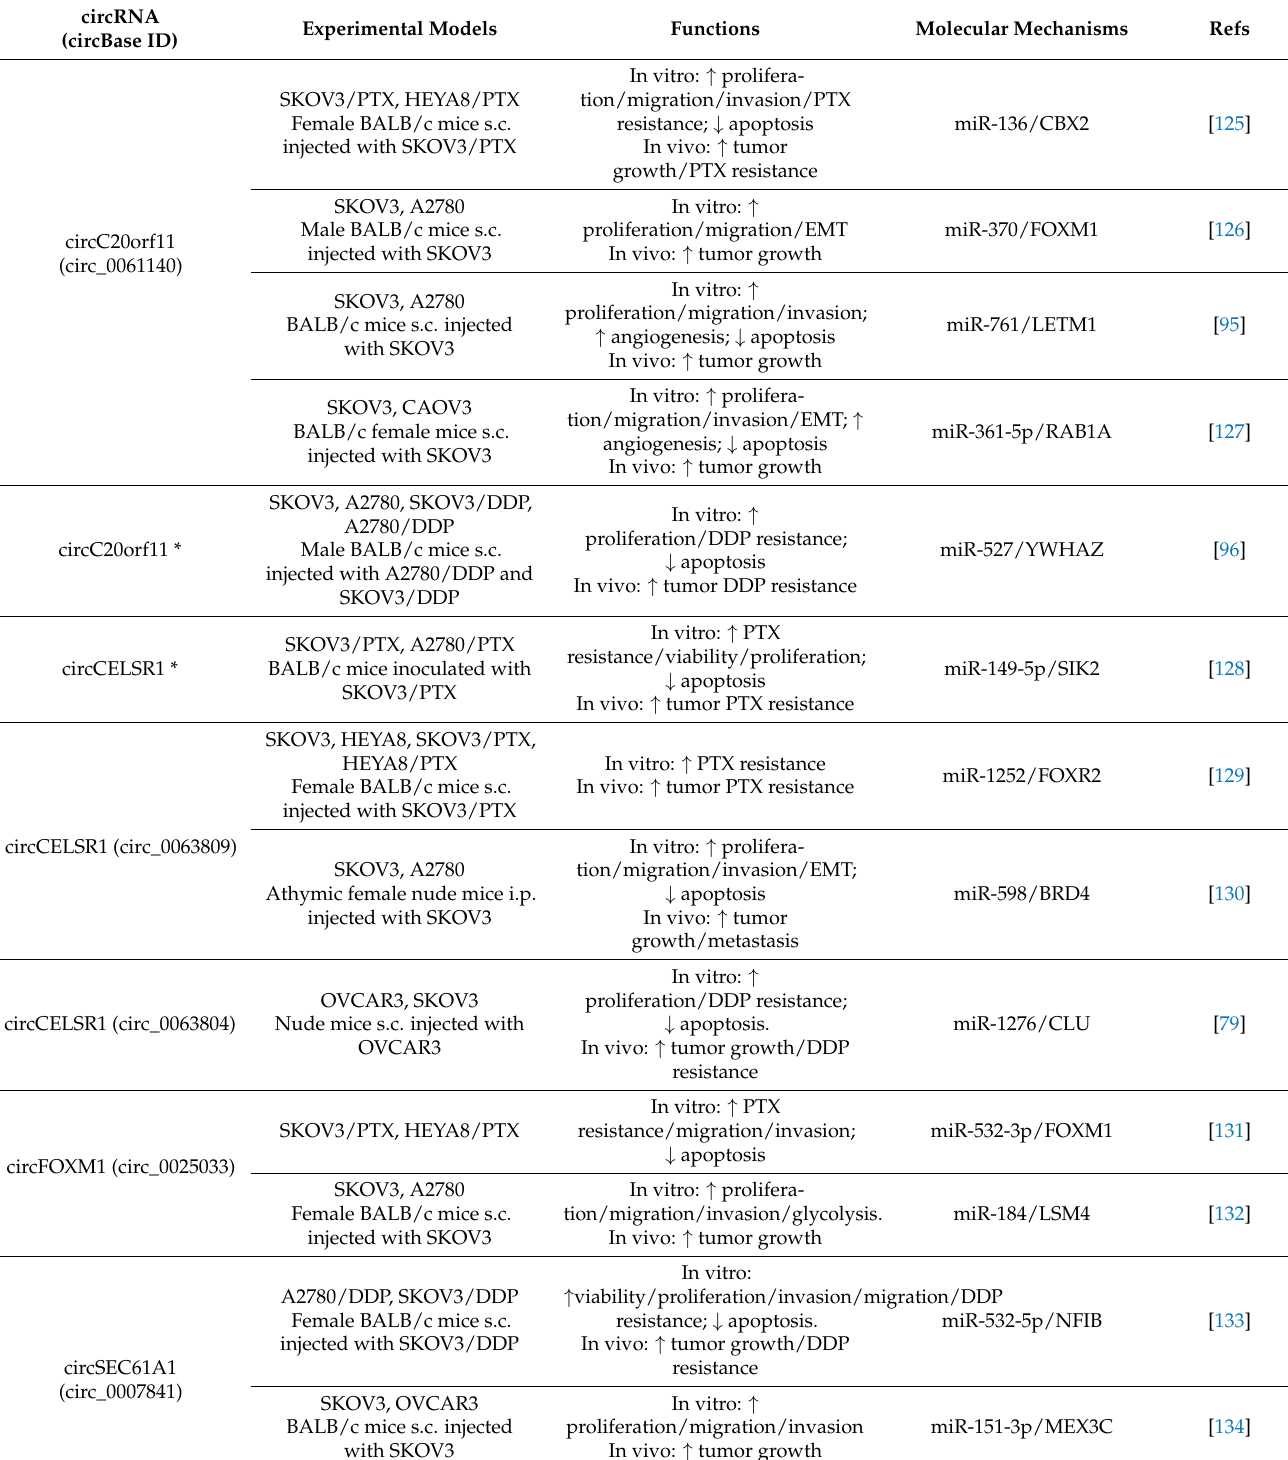
Table 2. Effects of circRNAs in